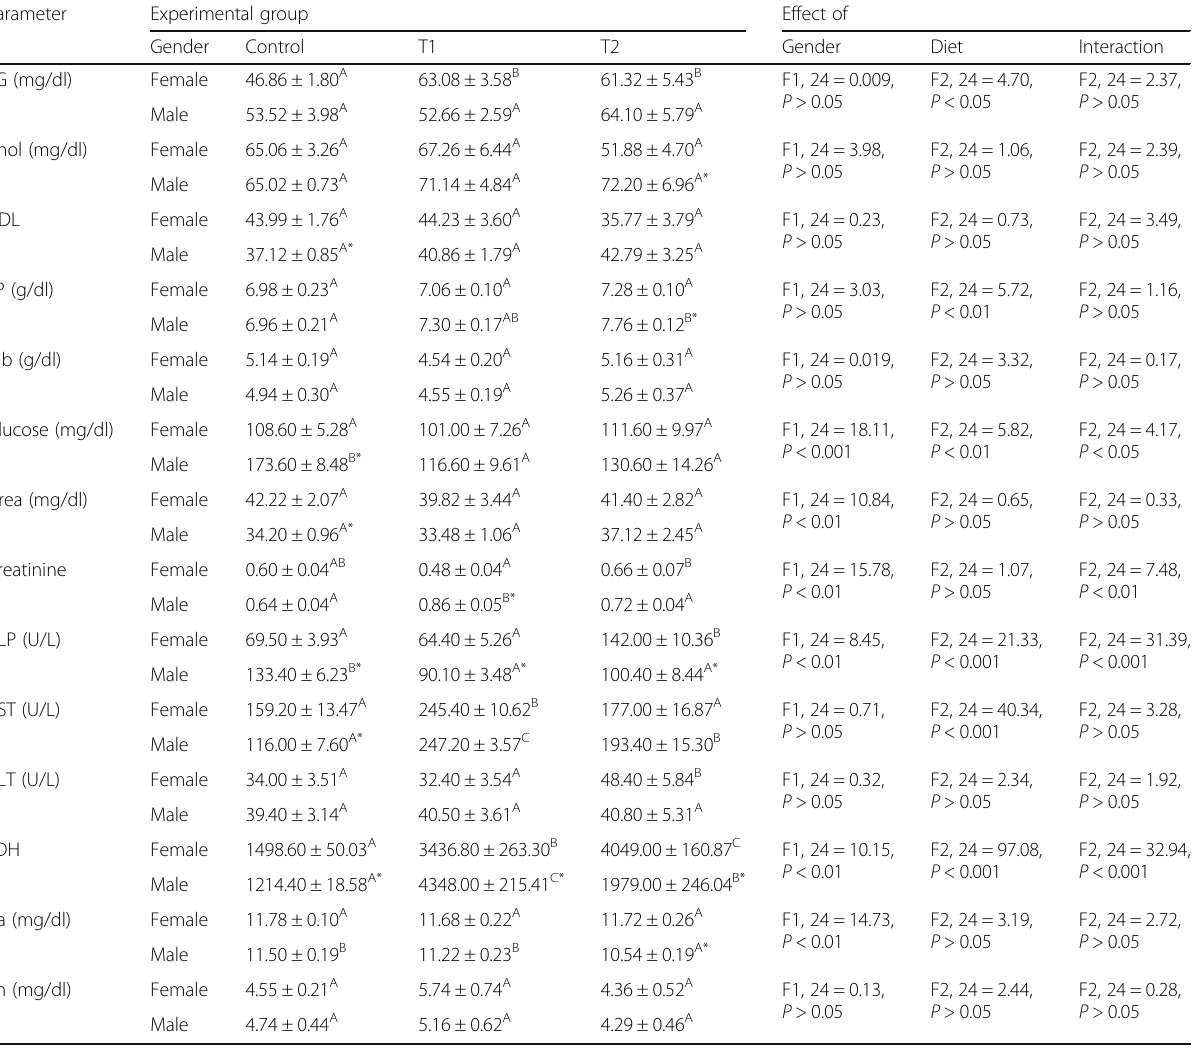
* Represents significant differences ( P <0.05) in comparison to the corresponding female groups. In each row, the mean values marked with the same superscript letter are similar (insignificant, P >0.05) whereas those with different ones are significantly differed ( P <0.05). P >0.05: insignificant, P <0.05, P <0.01 and P <0.001: significant effect at α =0.05, 0.01, and 0.001,